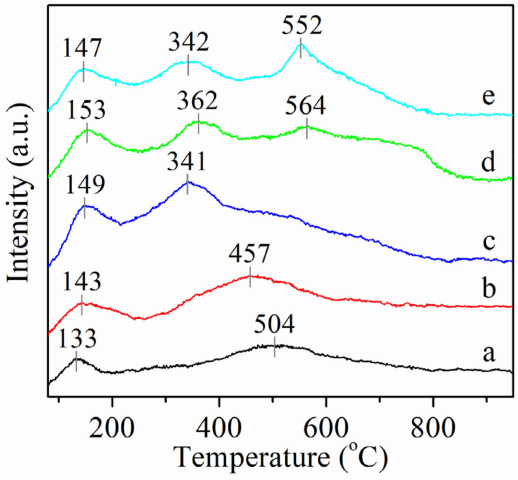
Figure 9. CO 2 -TPD profiles of the catalysts. (a) Ho 2 O 3 -NP, (b) Ho 2 O 3 -NS, (c) 0.02Sr-Ho 2 O 3 -NS,